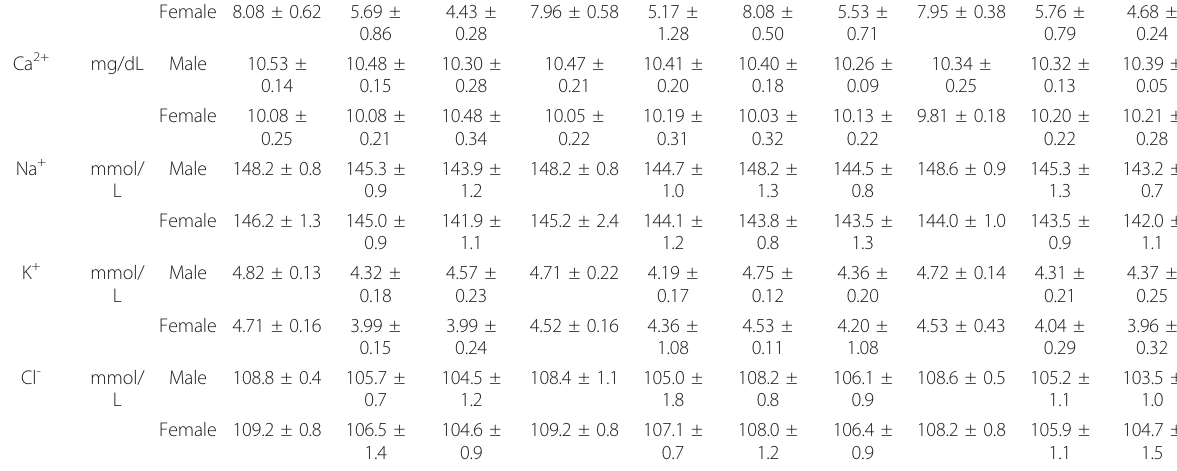
Table 4 Serum biochemical values in rats orally treated with PM012 (Continued)